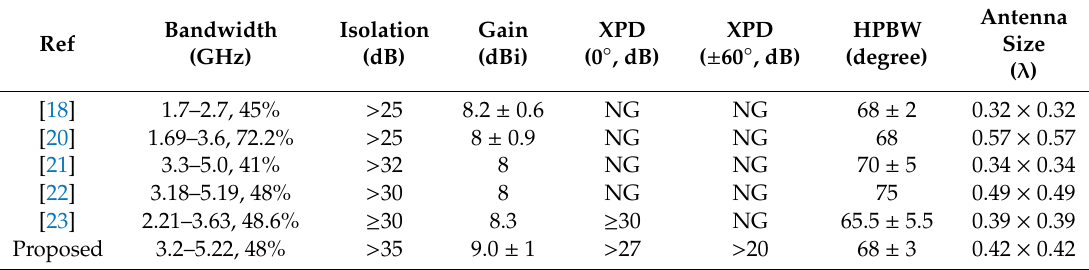
Table 2. Comparison of recent broadband